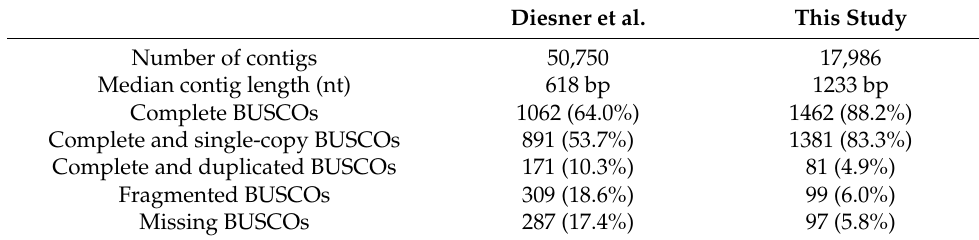
Table 1. A. ipsilon brain transcriptome assembly